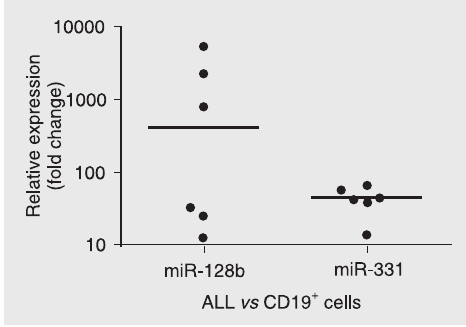
Figure 1. Expression values for miR-331 and miR-128b in six acute lymphocytic leukemia (ALL) samples analyzed indi- vidually, to validate the results found for those pooled samples. The fold change is the 2 - ∆∆ Ct value, calculated with the mean ∆ Ct value obtained for CD19 + samples